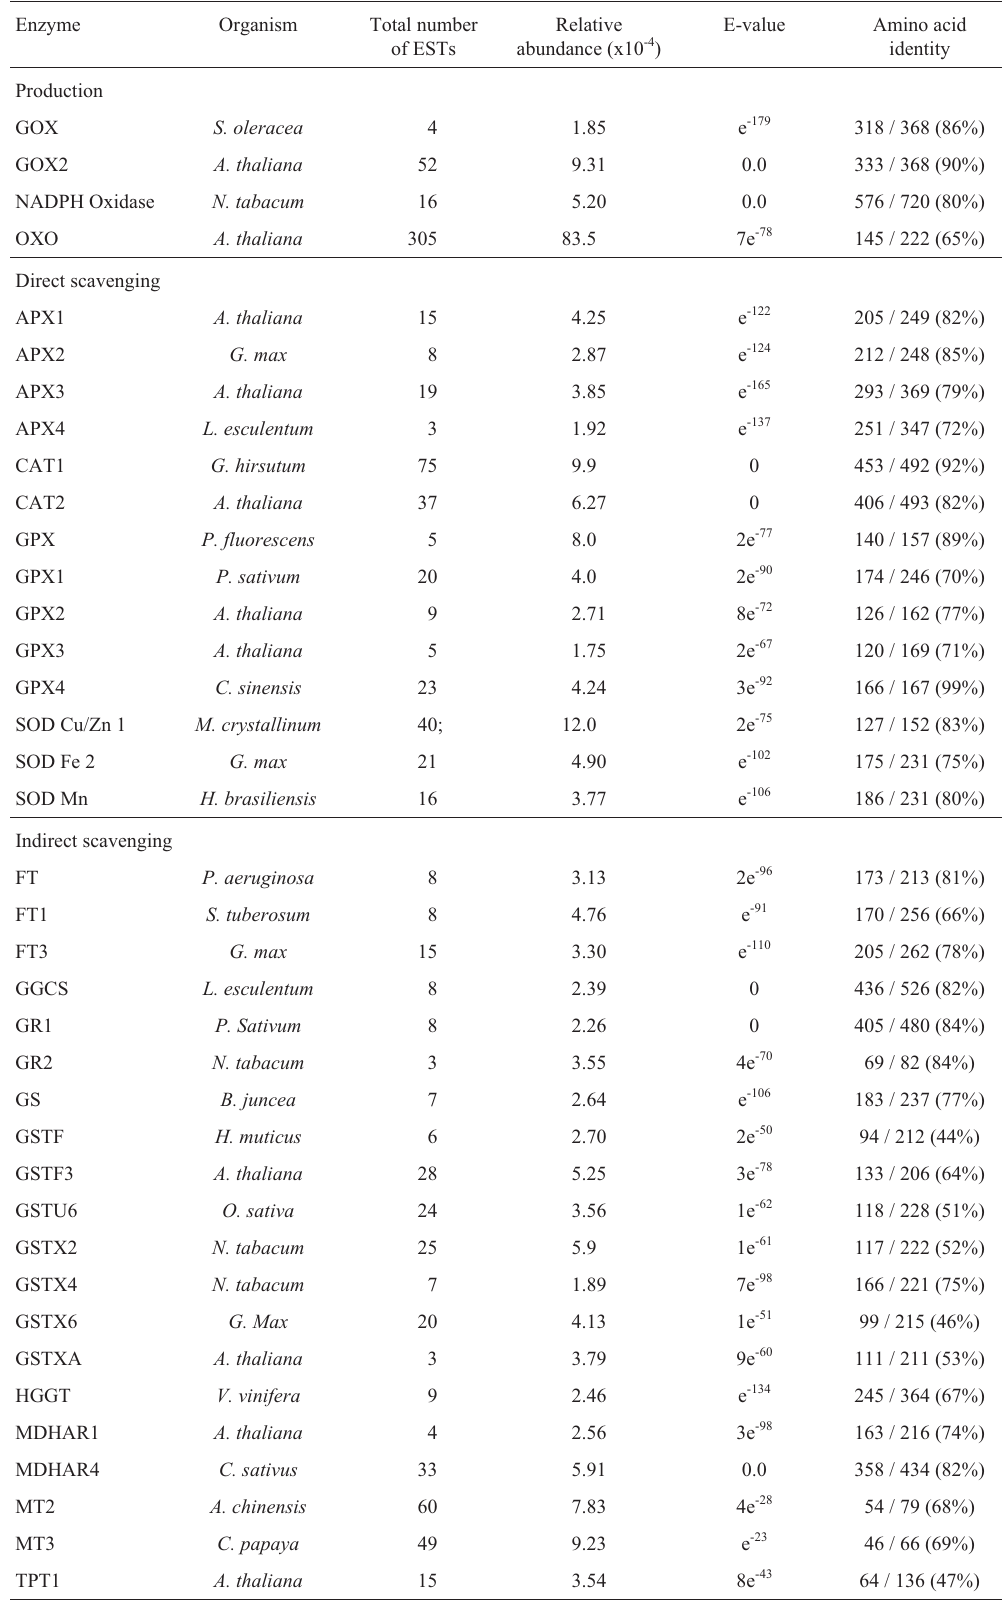
E-value Amino acid Relative identity of ESTs abundance (x10 -4 )